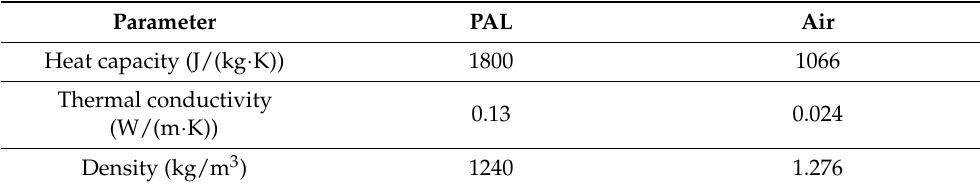
Table 1. Material thermal properties used in Comsol Multiphysics model.